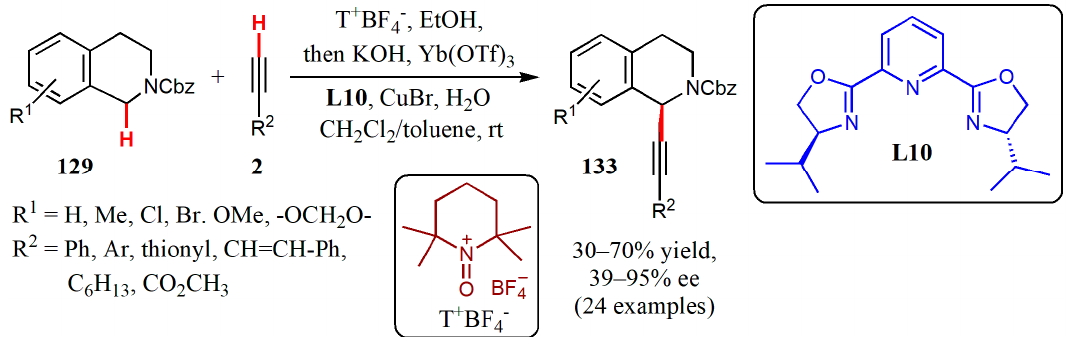
Figure 42. Enantioselective CDC of Cbz-protected THIQs with alkynes.